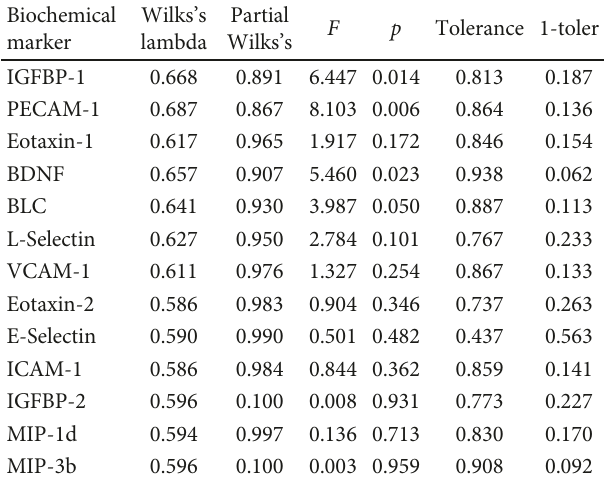
Table 4: Predictive value of selected markers marked with discriminant analysis by stepwise forward selection